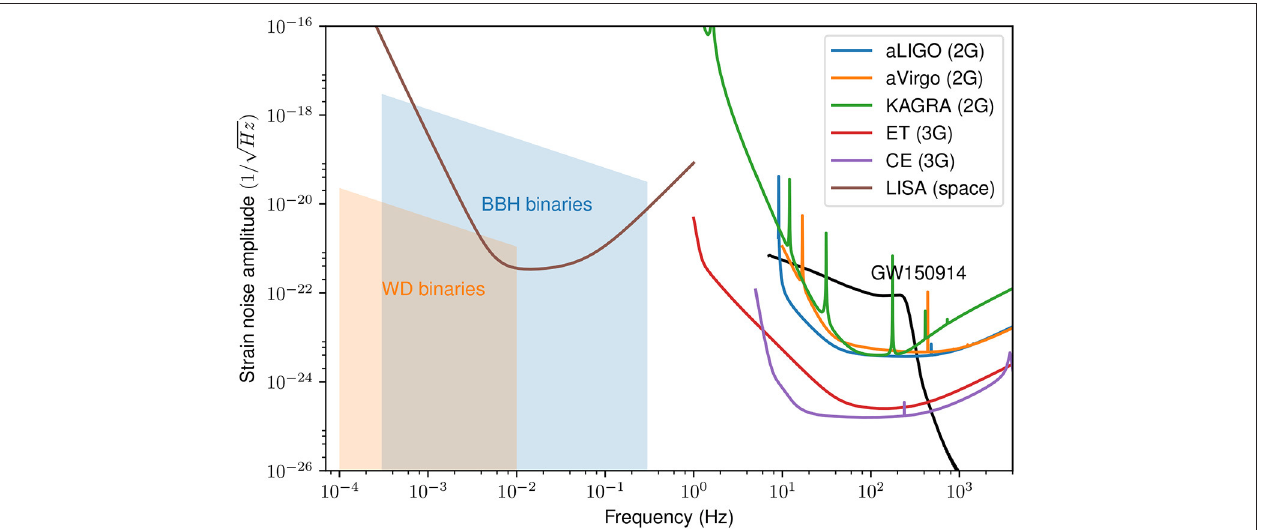
FIGURE 7 | Strain sensitivity curves for different GW detectors. Second generation (2G) ground-based detectors are advanced LIGO (aLIGO), advanced Virgo (aVirgo) and KAGRA, with curves given at design sensitivity ( Abbott et al., 2018e). Third generation (3G) detectors projected are Einstein Telescope (ET) (Sathyaprakash et al., 2012 ) and Cosmic Explorer (CE) (Abbott et al., 2017c). A space-based detector planned is LISA (Amaro-Seoane et al., 2013). For illustration, we include the strain amplitude of GW150914 (Vallisneri et al., 2015) and the expected background for massive binary black-holes (BBH) and galactic white-dwarf (WD) binaries (Moore et al., 2015